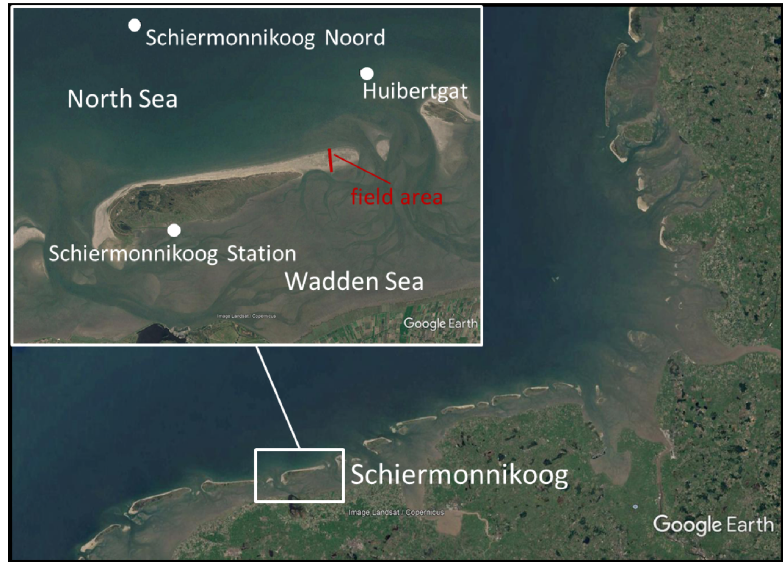
Figure 1. The barrier island of Schiermonnikoog is located in the North Sea and is separated from the Dutch coast by the Wadden Sea. The field site was located on the eastern tip of the island, indicated in